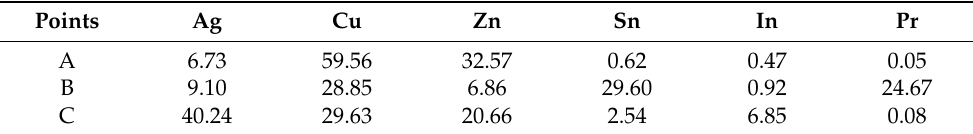
Table 4. EDS analysis results of the points indicated in Figure 8 (at.%).